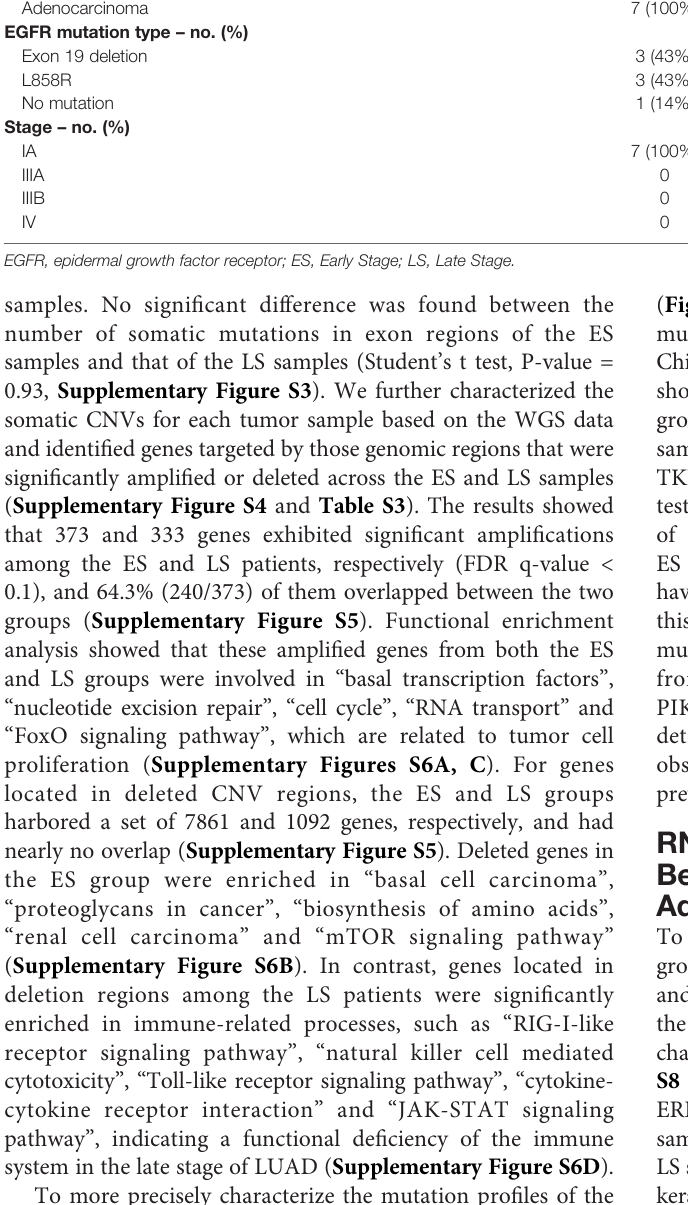
TABLE 1 | Clinical Characteristics of early and late stage of LUAD patients. Characteristics